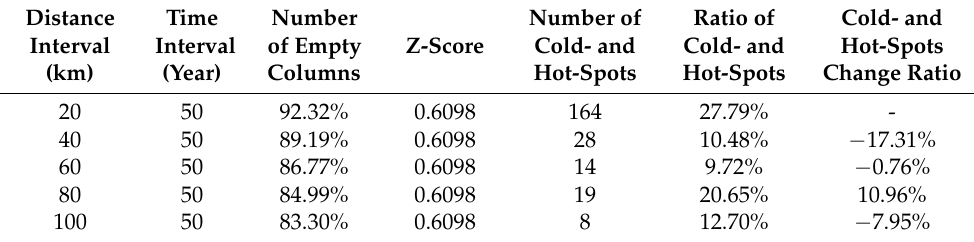
Table 3. Space-time cube spatio-temporal scale effect (Distance).